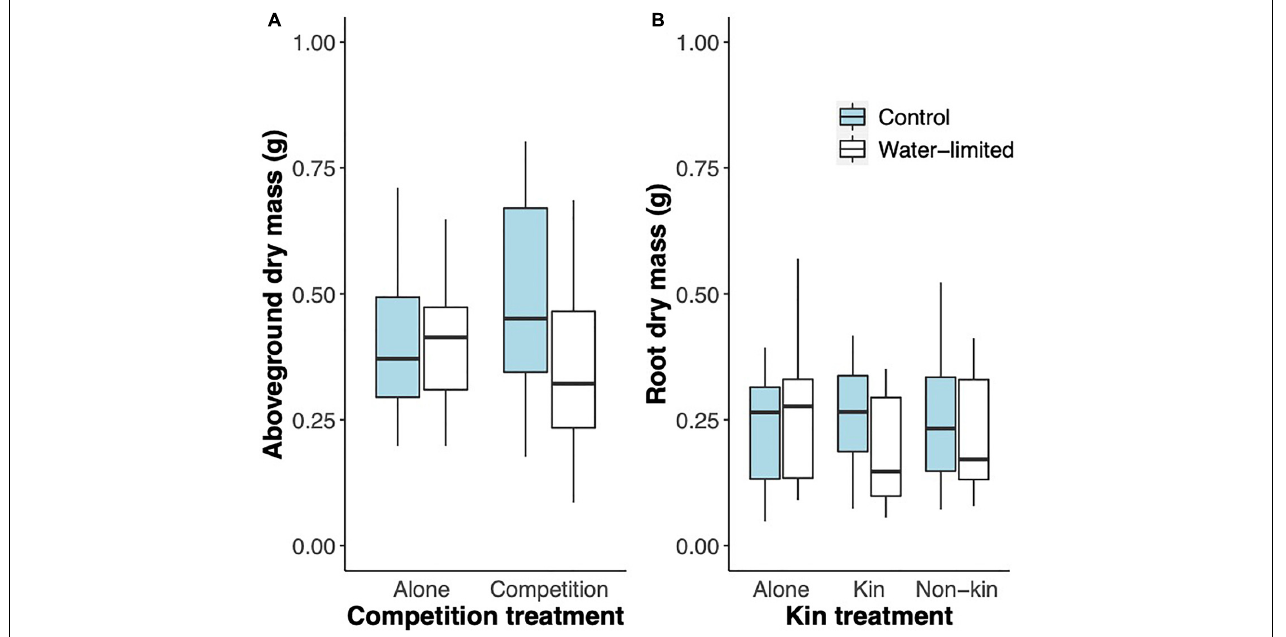
FIGURE 5 | Boxplot of (A) aboveground dry mass and (B) root dry mass (g) accumulated for Glechoma hederacea plants grown for 36 days either alone, or in competition with a kin or a non-kin plant under control (blue boxes) and water-limited (white boxes) conditions in Experiment 2: